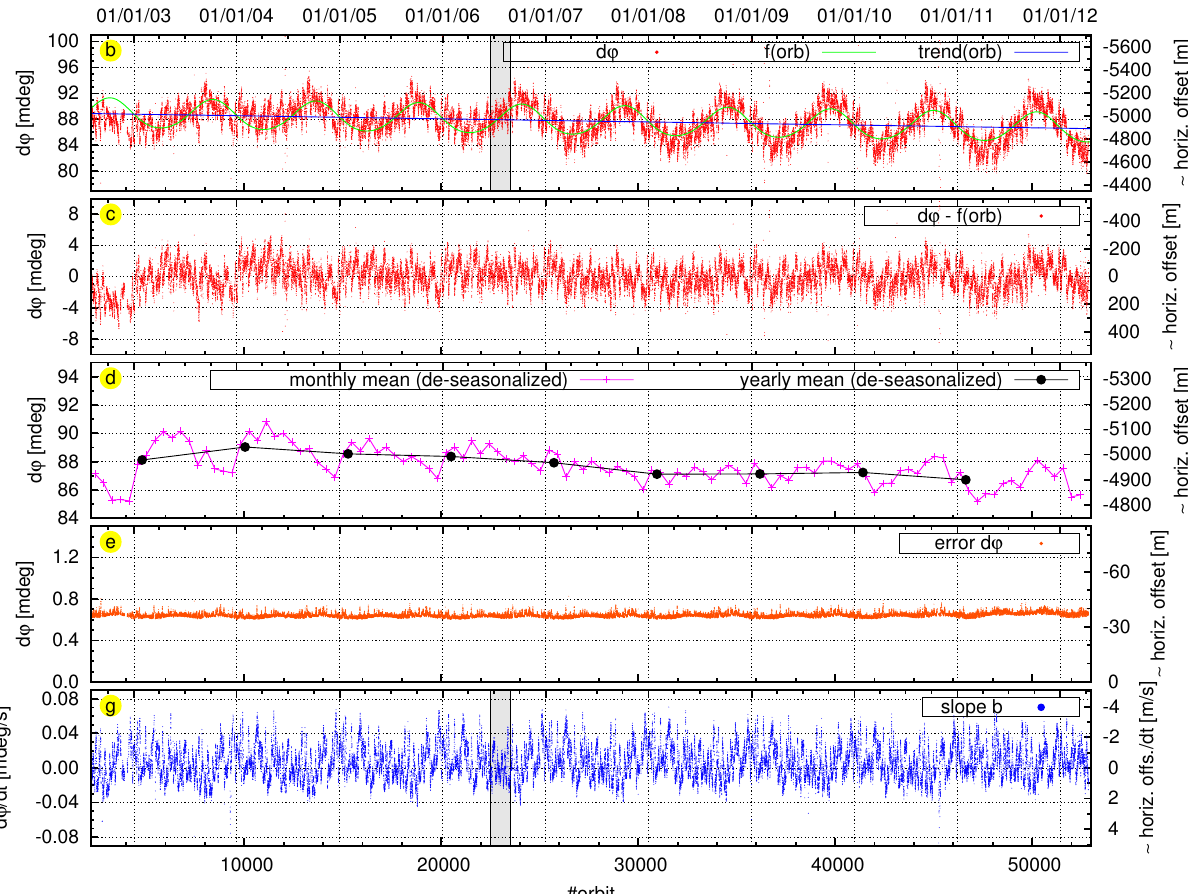
Fig. 13. Time series of the AAO dϕ , derived from the adjustment of the azimuth mirror by the Sun follower device (SFD). The plots corresponds to Fig. 9 (b–e) and (g) for the elevation angle. Zooms of the gray bars in (b) and (g) are shown in Fig.